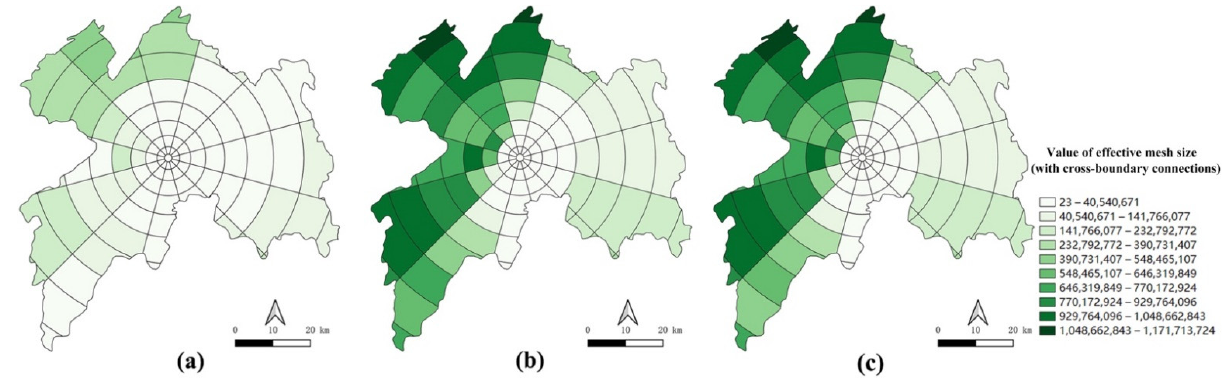
Figure 9. Results of the value of effective mesh size of forest land use in Enshi City. ( a ) Results from 2000; ( b ) Results from 2010; ( c ) Results from 2020.